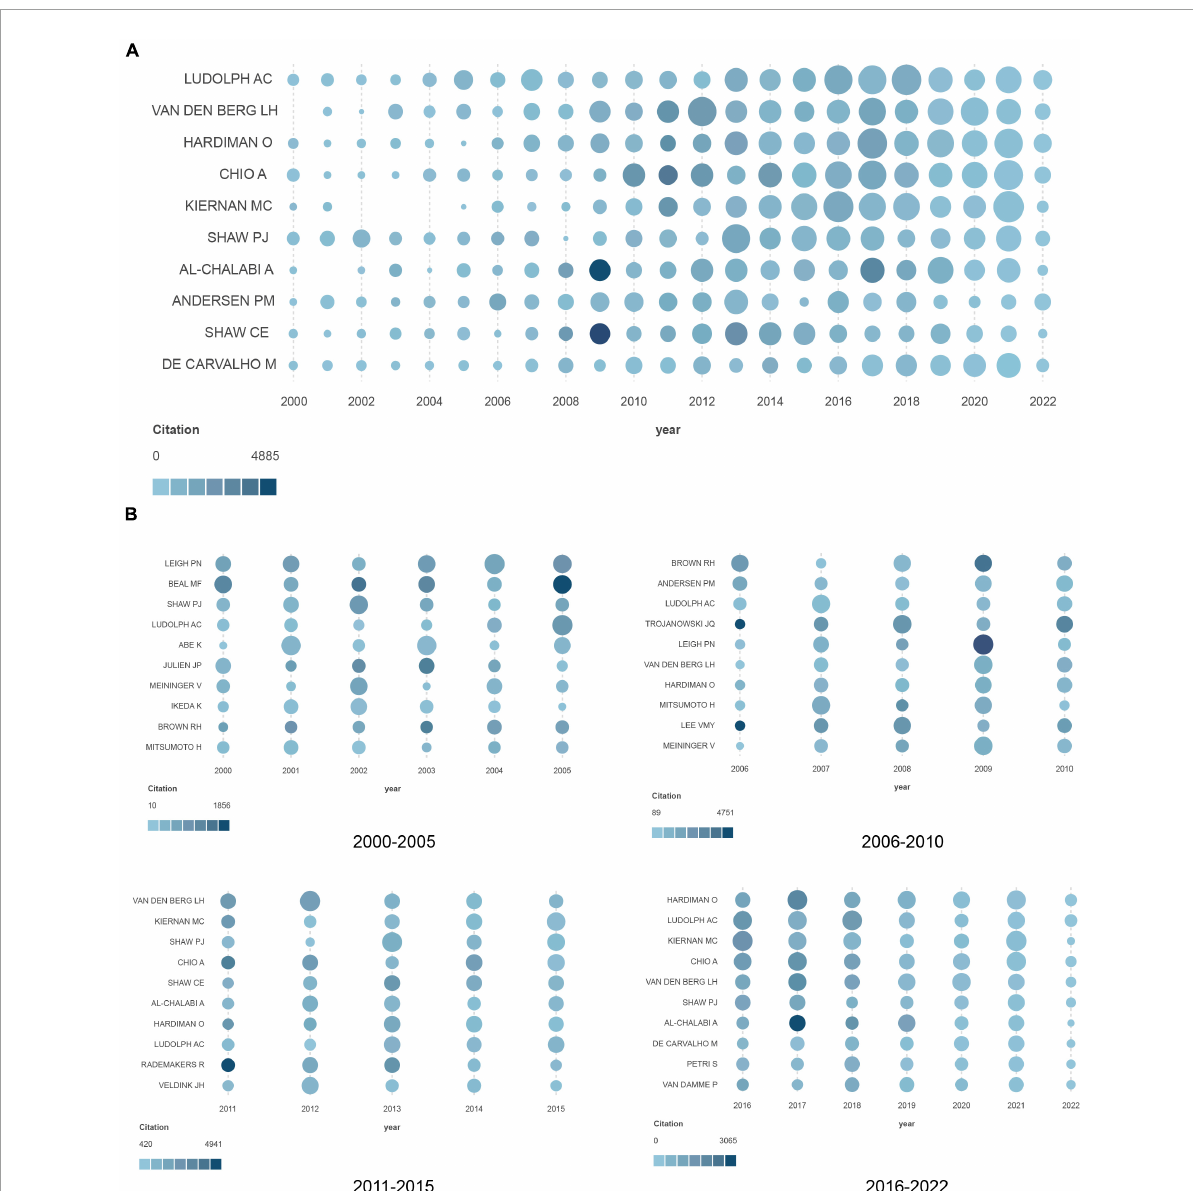
FIGURE2 (A) Productivity over time of the top 10 most productive authors. (B) Output of the 10 most productive authors in different periods (the circle size represents the number of articles published by the authors, while the number of citations per article is expressed by the depth of the color).